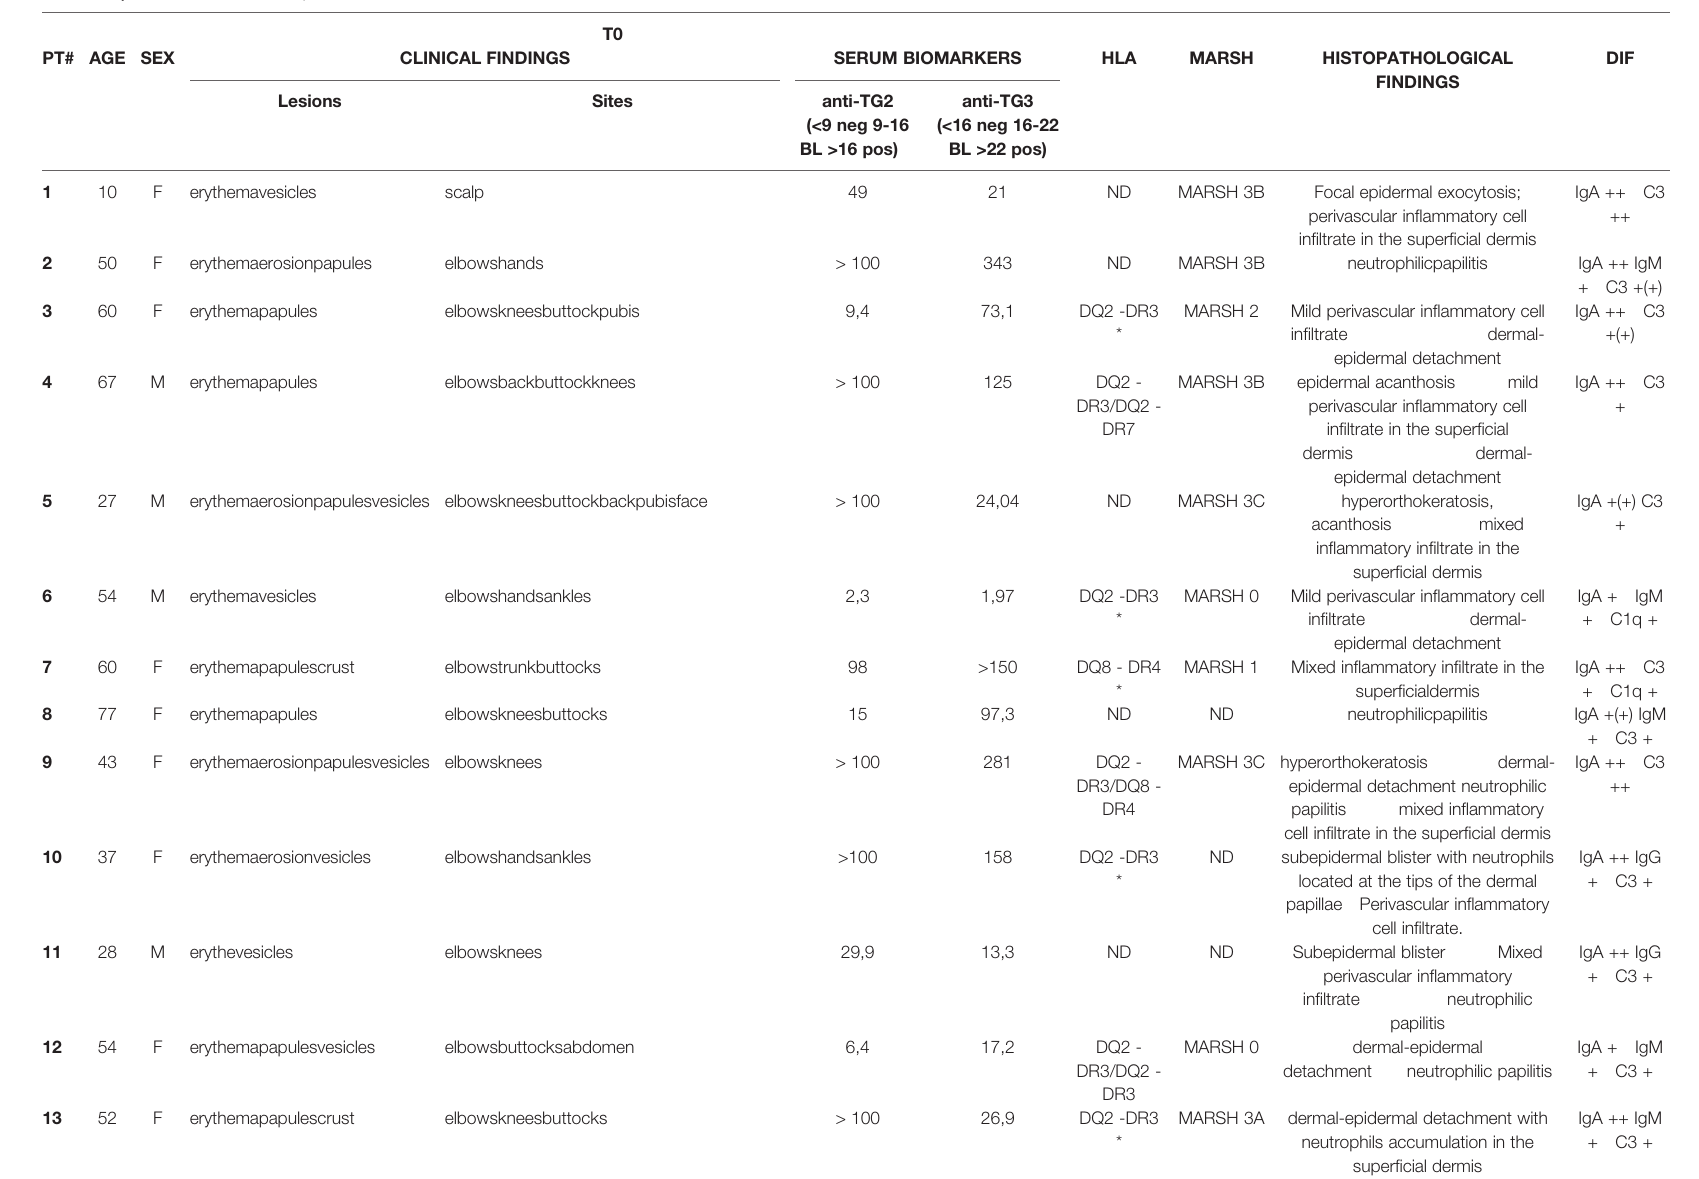
TABLE 1 | Clinical features of CD patients with